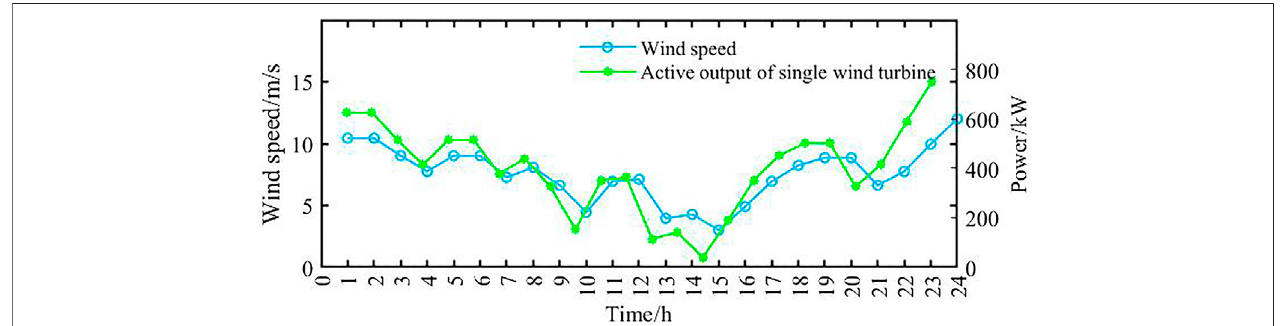
FIGURE 5 | Forecast values of wind speed and a single wind turbine ’ s output during the day to be dispatched.